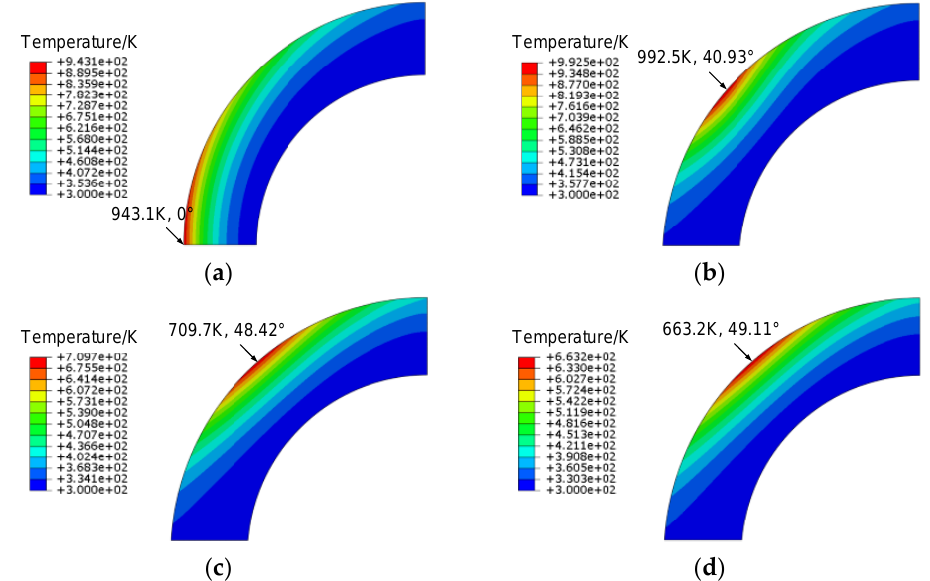
Figure 13. Comparison of structural temperature field of the forebody at 20 s: ( a ) Model 1; ( b ) Model 2; ( c ) Model 3; ( d ) Model 4.